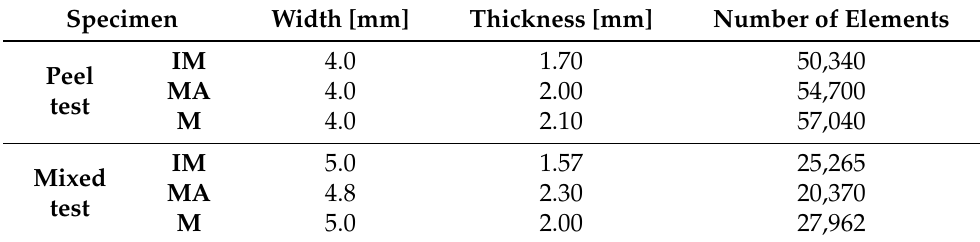
Table 1. Dimensions and number of elements of each model.